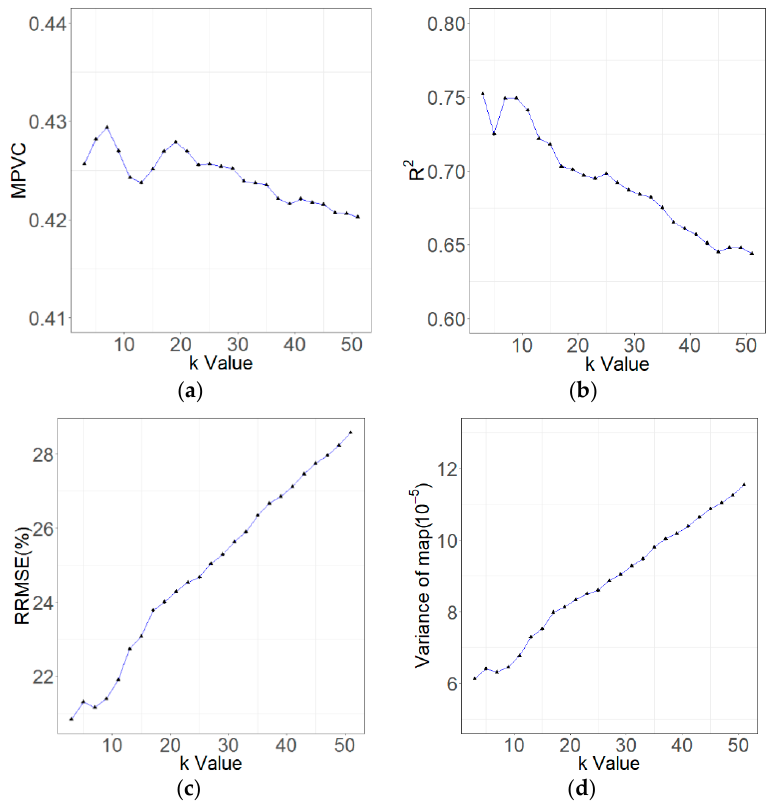
Figure 8. The accuracy assessment results of PVC predictions for Kangbao County using Cons-kNN with 25 different k and leave-one-out cross validation based on the whole dataset: ( a ) mean prediction of plot percentage vegetation cover (MPVC) (confidence interval: 0.40–0.46); ( b ) coefficient of determination, R 2 ; ( c ) relative root mean square error (RRMSE); and ( d ) variance of the predicted PVC values for the maps ( VAR map ).